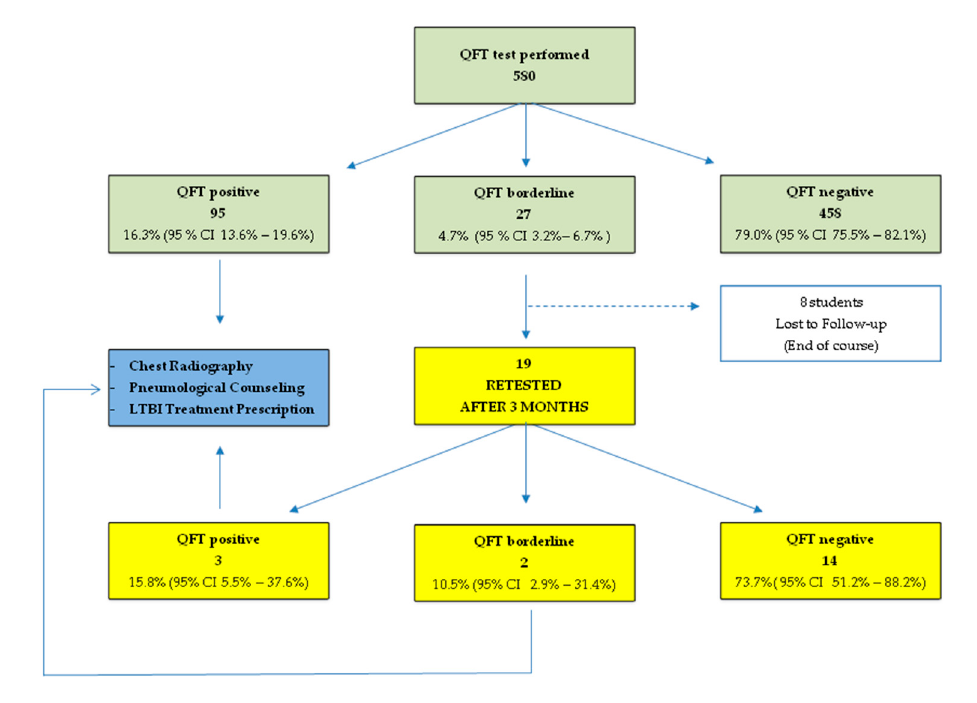
Figure 1. Management of the subjects that performed the QuantiFERON-TB ® Gold In-Tube assay (QFT–GIT). In green the first level exams; in yellow the second-level tests; in blue the third level intervention. LTBI: latent tuberculosis infection; CI: confidence interval.